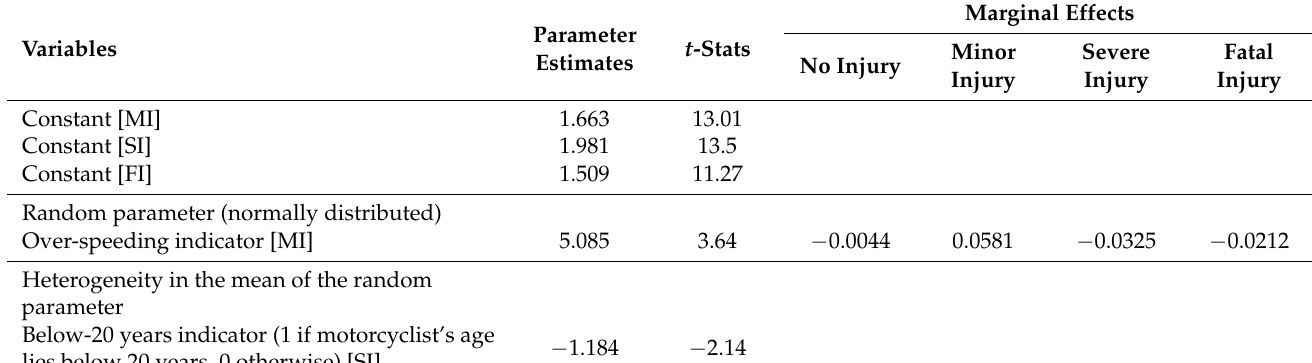
Table 10. Model estimation results for non-helmet-wearing motorcycle crashes